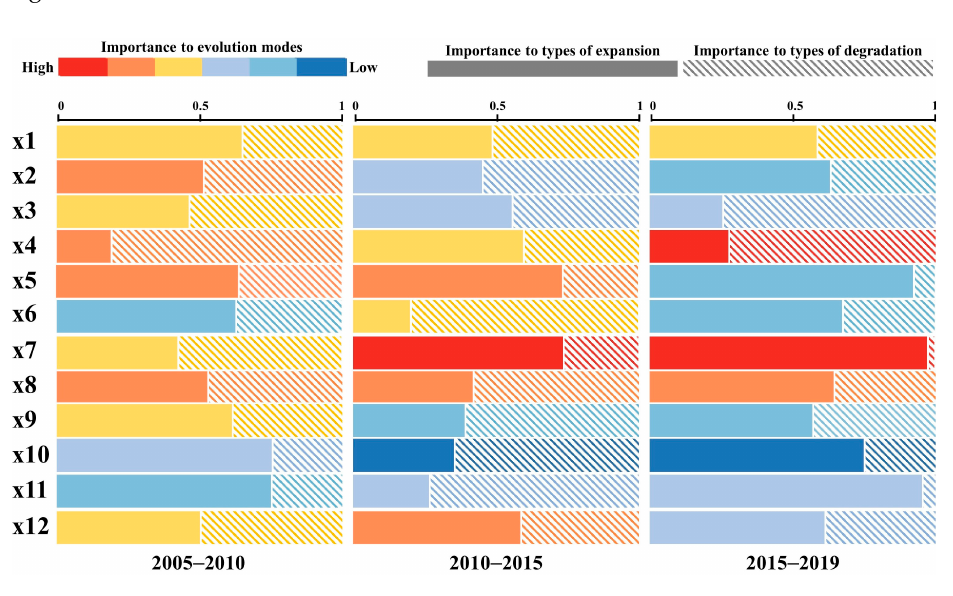
Figure 8. Variable importance of driving variables to evolution modes and specific types.